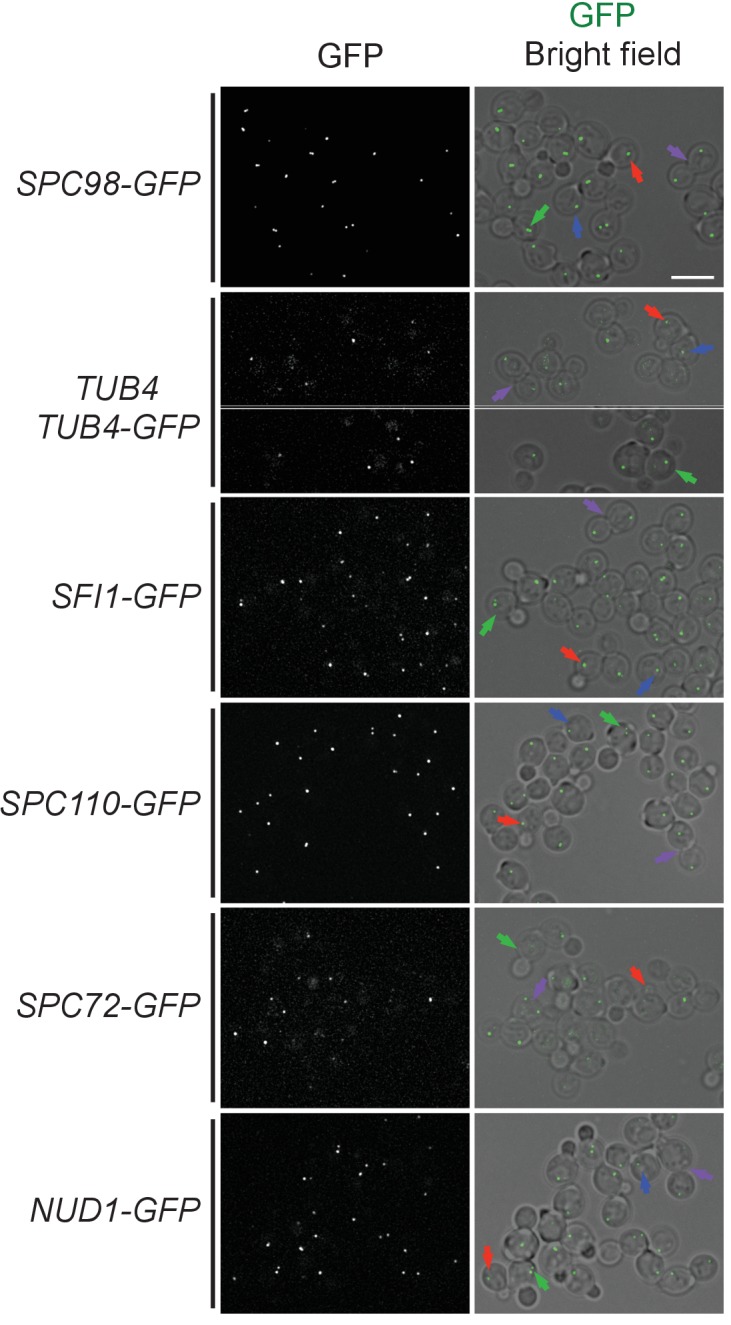
SPB localization of O. polymorpha orthologues of SPB components and γ-TuSC components.Cells were logarithmically growing in YPDS expressing GFP-fusion proteins of Spc98, Tub4, Sfi1, Spc110, Spc72, and Nud1 orthologues (HPH475, HPH41, HPH1400, HPH1405, HPH1394, and HPH1396). Cells at different cell cycle stages are marked with arrows. G1, blue; 1SPB, red; 2SPBs, green; Anaphase, purple. Shown are deconvolved and projected images. Scale bar, 5 µm. GFP intensity is not scaled among the strains. Note that while all GFP-fusion proteins were sole source of these proteins, TUB4-GFP cells carried both untagged TUB4 gene at endogenous locus and PTUB4-TUB4-GFP gene at exogenous locus.